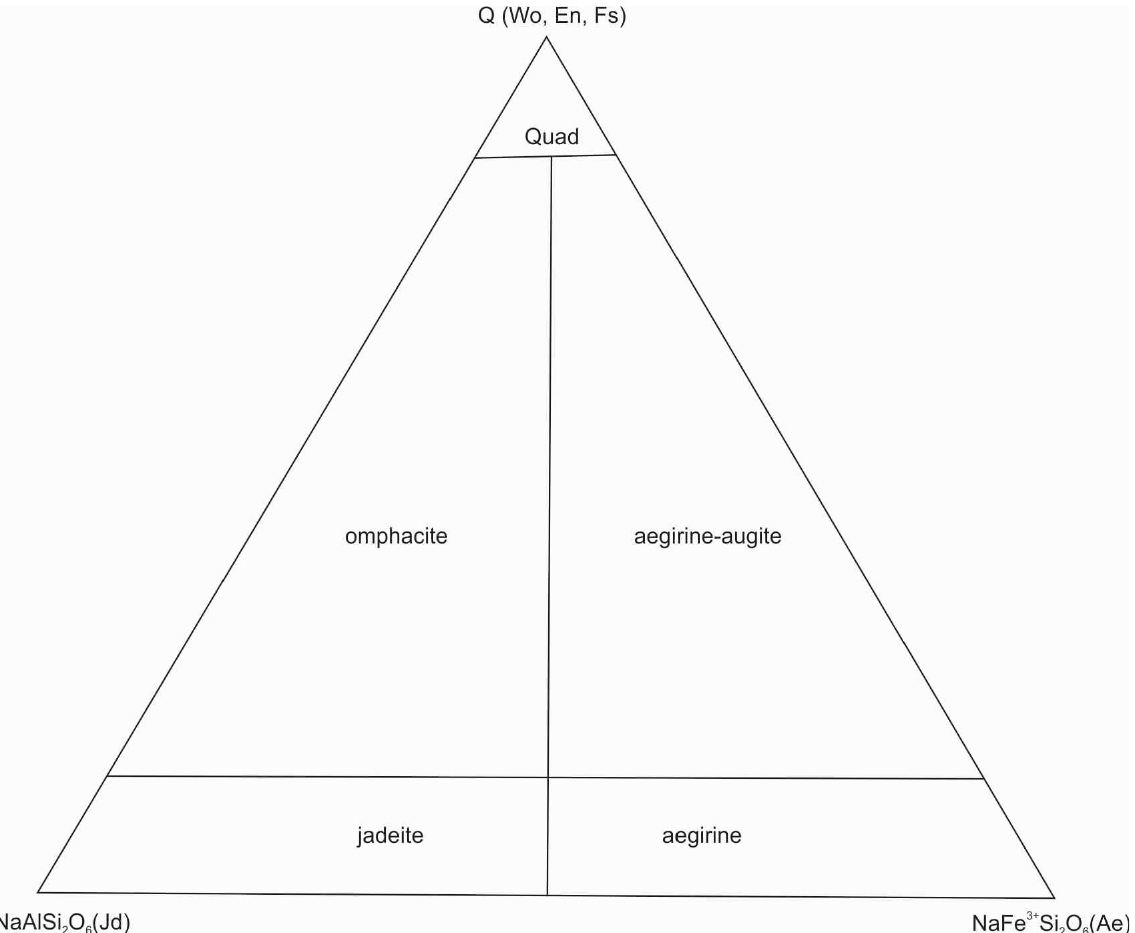
Figure 1. Simplified ternary diagram of Na-pyroxenes. Q: QUAD; Wo: wollastonite; En: enstatite; Fs: ferrosilite; Jd: jadeite; Ae: aegirine. Modified from Morimoto et al.